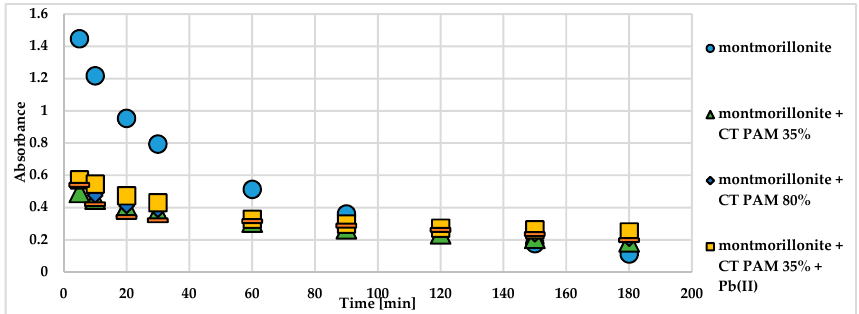
Figure 2. Influence of CT PAM and Pb(II) addition on the montmorillonite suspension